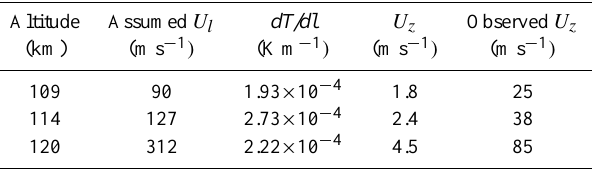
Table 1. Summary of estimated dT/dl (third column from left) and U z (fourth column) from Eq. (5) at 109, 114, and 120km heights. These values were calculated using EISCAT measurements con- ducted on 9 September 2004 at 23:00UT. The last column shows the observed vertical-wind speed as a